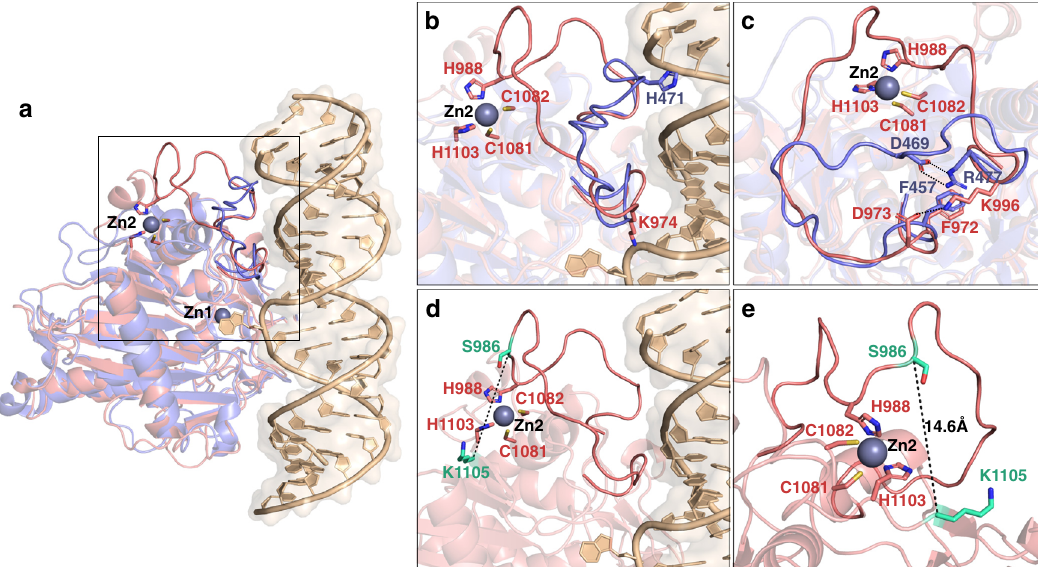
Fig. 8 Comparison of a hADAR1d model with the crystal structure of an hADAR2d-RNA complex 21 and chemical cross-linking mass spectrometry (XL-MS) using a DSBU cross-linker. a A representative hADAR1d model (in salmon) is superimposed on crystal structure of a hADAR2d-RNA complex (in blue and RNA in wheat), showing the 5 ′ binding loop of each protein and the second metal-binding site of hADAR1d. Zn1 is a catalytic zinc at the active site and Zn2 is bound in the second metal site reported here. b Close-up of the 5 ′ binding loop of each protein and the second metal-binding site of hADAR1d. H471 residue in hADAR2d is a RNA contacting residue seen in the crystal structure of hADAR2d. K974 is a possible RNA contacting residue predicted from the hADAR1d model structure. c Close-up comparison of the 5 ′ binding loop conformations of hADAR1 and hADAR2 and ionic and cation- π interactions of residues within each of the 5 ′ binding loop. d DSBU cross-linking between K1105 and S986 supports the conformation of the 5 ′ binding loop observed from hADAR1d model structure. e Close-up view of the cross-linking of K1105-S986 nearby the second zinc-binding site, showing C α -C α distance of 14.6